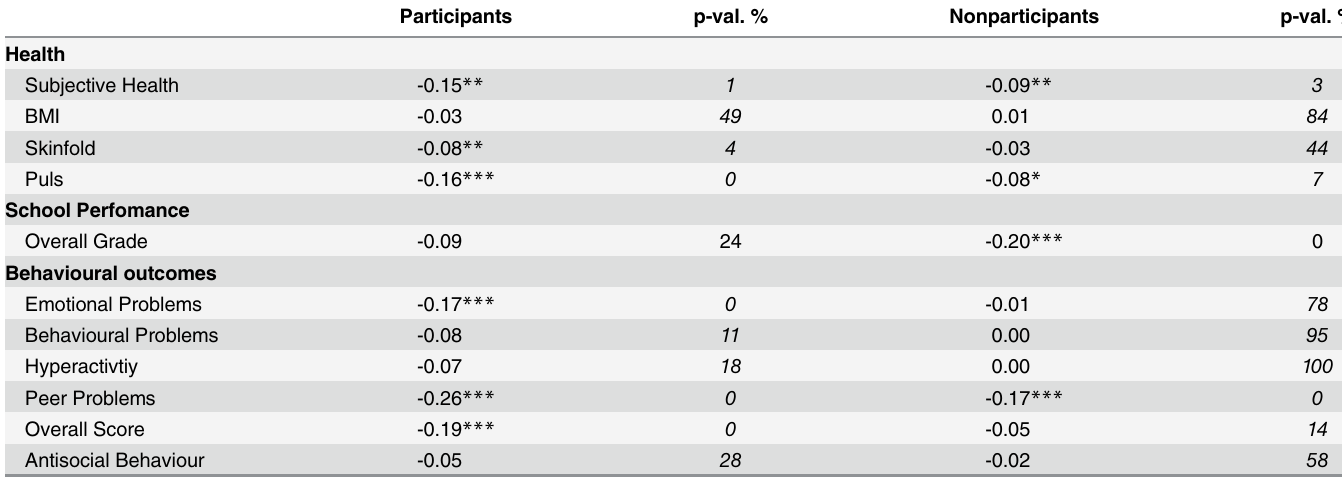
Table 7. Average effects for participants and nonparticipants (KiGGS). Note: p-values are computed by bootstrapping p-values of the t-statistic with 4999 replications. All variables are standardized to mean zero and variance